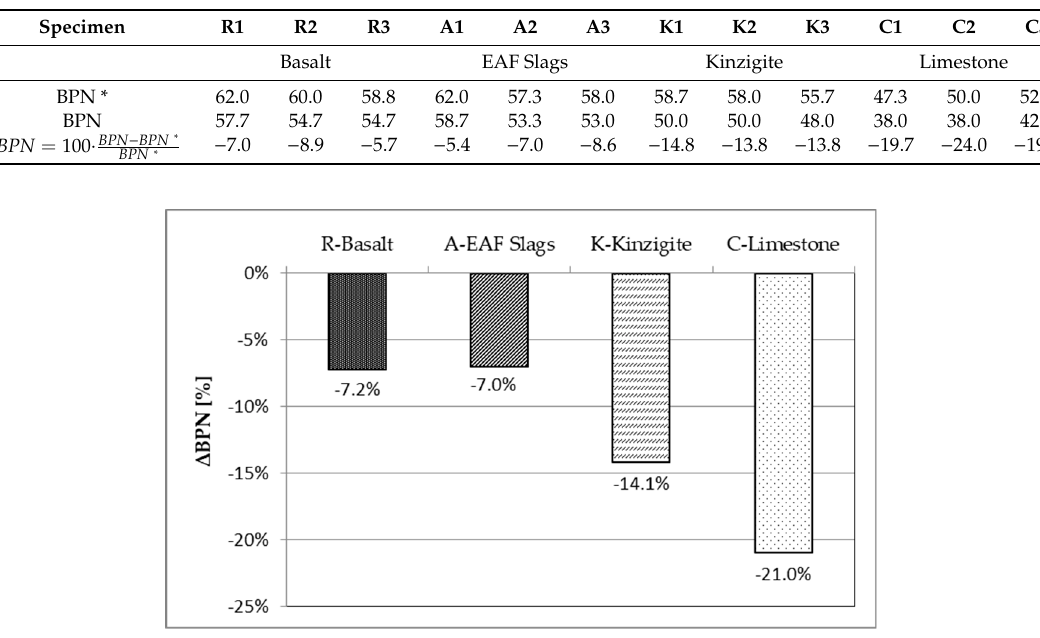
Figure 6. Average Δ BPN% (British Pendulum Number) for each aggregate after the accelerated Figure 6. Average ∆ BPN% (British Pendulum Number) for each aggregate after the accelerated polishing process. polishing